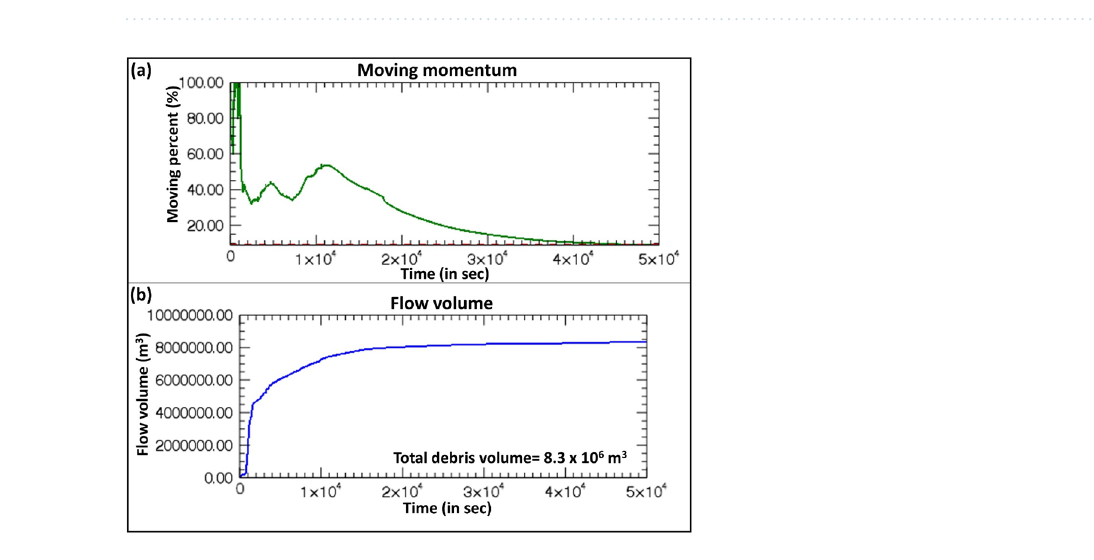
Figure 8. ( a ) Moving momentum (%) of the modeled GLOF/debris flow vs. time (in sec); ( b ) total flow volume (m 3 ) vs. time (in